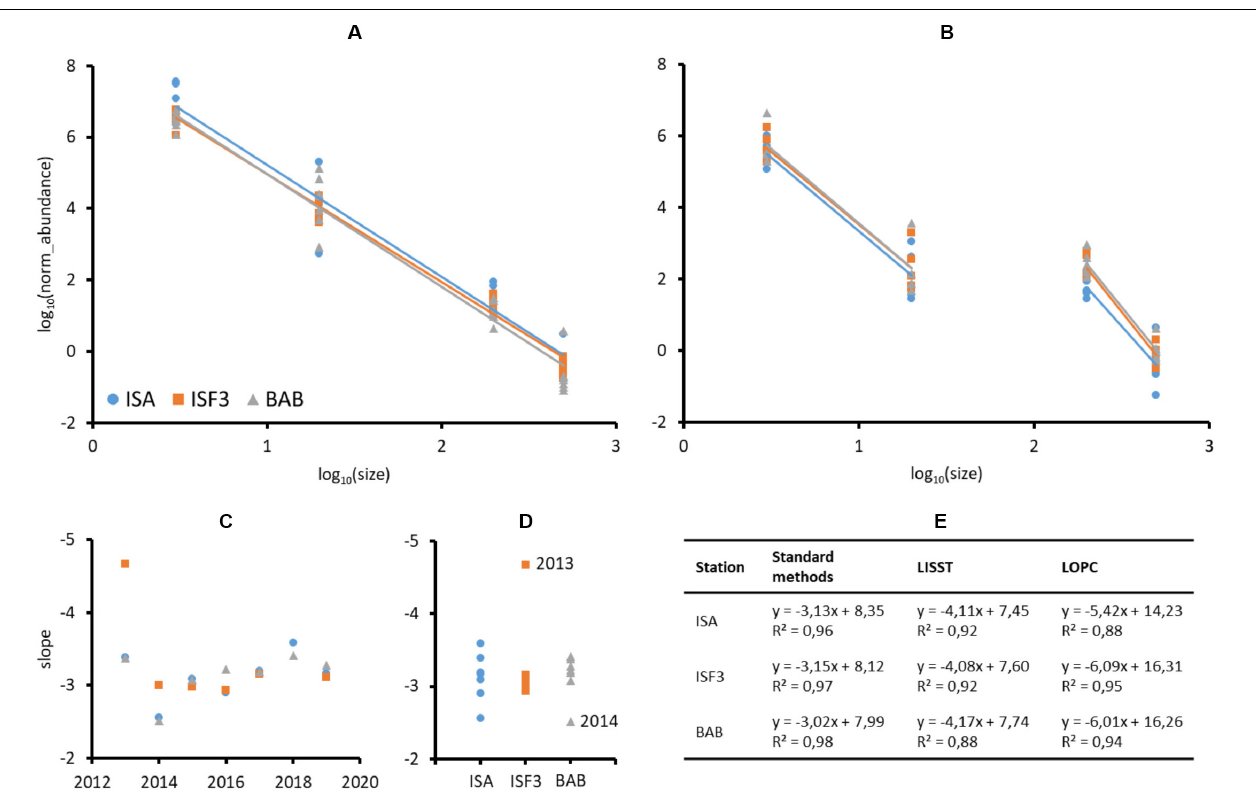
FIGURE 6 | Log-transformed normalized abundances of plankton (A) and P&P (B) size fractions (individuals · m − 3 and counts · m − 3 ) at three Isfjorden stations: ISA, ISF3, and BAB in seven consecutive mid-summers (2013–2019). Slopes of the number spectrum fitted to plankton concentrations over years (C) and stations (D) . Table of linear fit equations and R-squared values obtained for standard methods and laser-based measurements of plankton and P&P abundance (E)